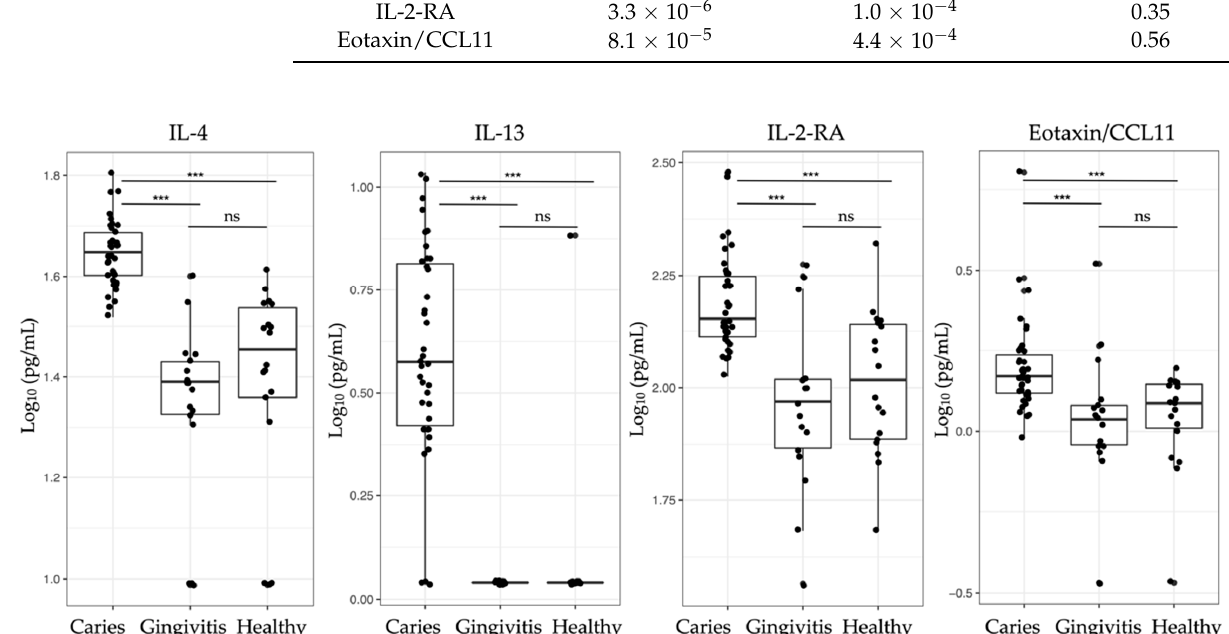
Figure 5. Boxplots of the four strongest group classifiers (IL-4, IL-13, IL-2-RA, and eotaxin/CCL11) based on random forest classification, with median values and interquartile ranges for each group shown (healthy individuals, patients with gingivitis, and those with caries). p -values were derived from Kruskal–Wallis tests followed by post hoc pairwise comparisons according to Conover. ns = p > 0.05; *** p ≤ 0.001 (see Table 1 for specific p -values). Table 1. p -values of the four biomarkers IL-4, IL-13, IL-2-RA, and eotaxin/CCL11 when comparing patients with caries, patients with gingivitis, and healthy individuals.